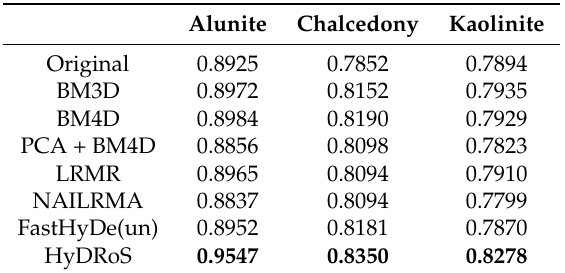
Figure 14. ROC curves for the three minerals obtained by SFF: ( a ) Alunite; ( b ) Chalcedony; ( c ) Kaolinite. Table 4. AUC obtained by SAM for Hyperion noise-reduced HSI data at Cuprite Mining